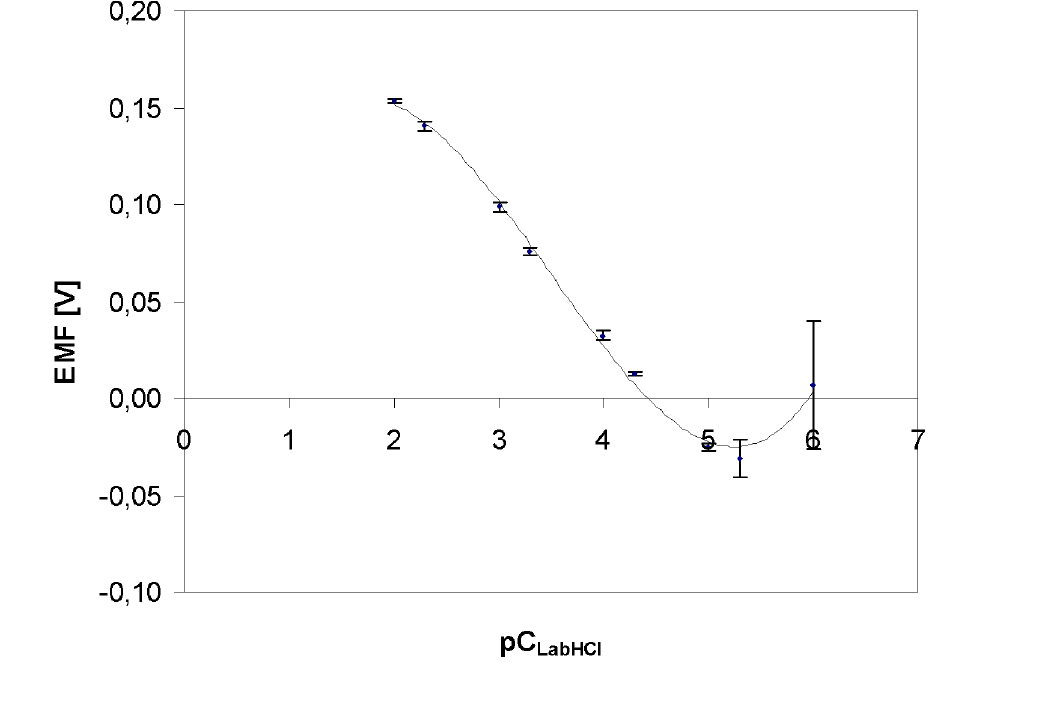
Fig. 2 Calibration curve obtained with